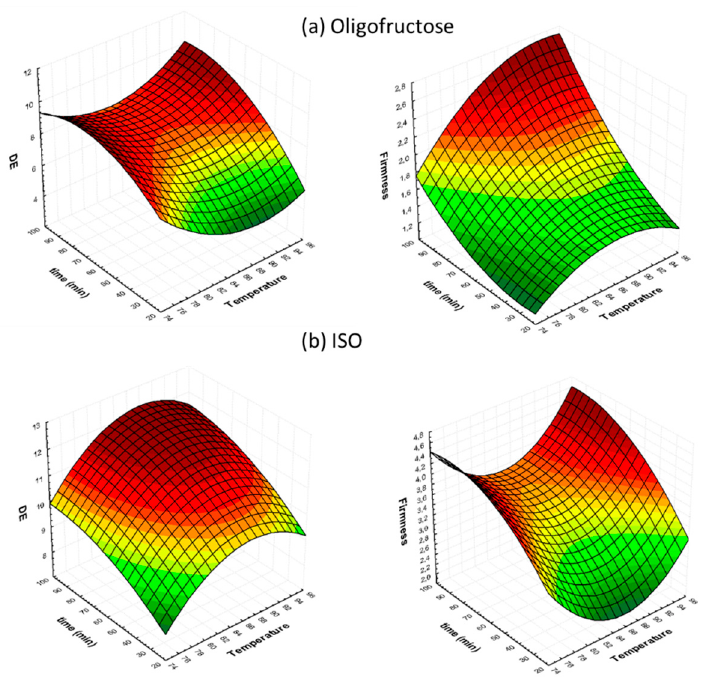
Figure 2. Three-dimensional Response Surface graphs for color change ( ∆ E) and firmness, as a function of process duration and temperature, at a fixed OD concentration of 70 ◦ Brix, in the case of: ( a ) O and ( b ) ISO osmotic solutions.